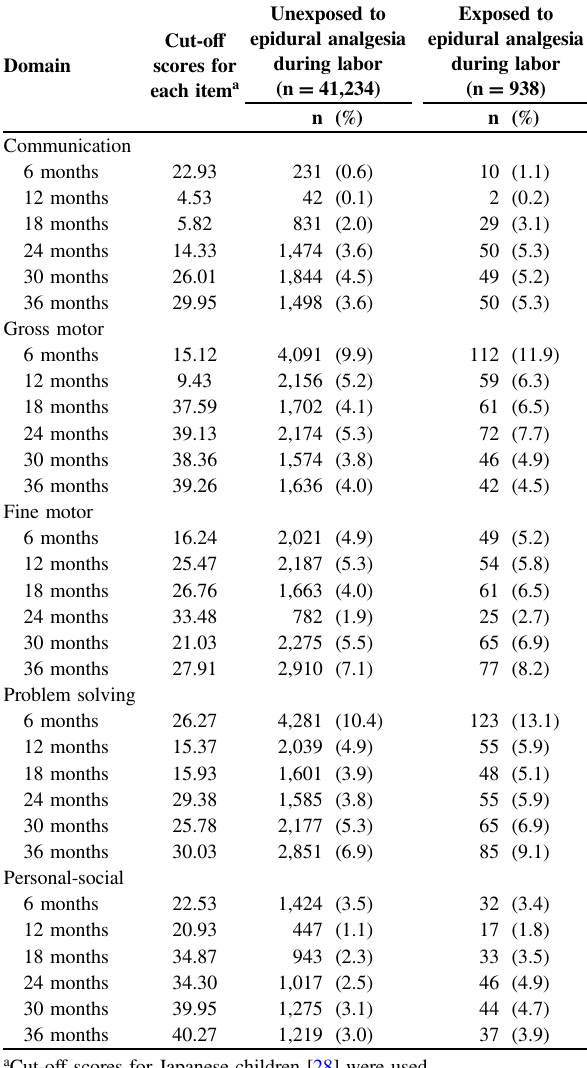
Table 2 Neurodevelopmental delay in each domain of the J-ASQ-3 among children, with or without epidural